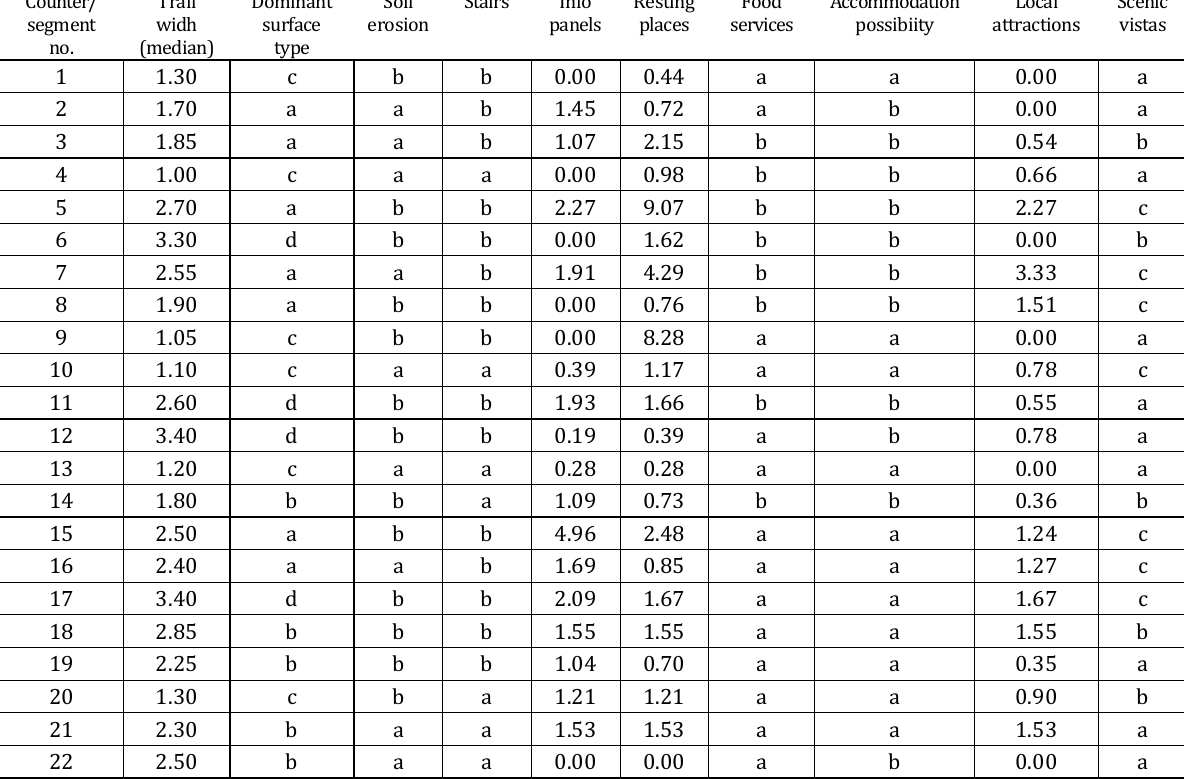
Table 3. Trail segment characteristics evaluated in the field (codes and scoring are explained in Table 1) Counter/